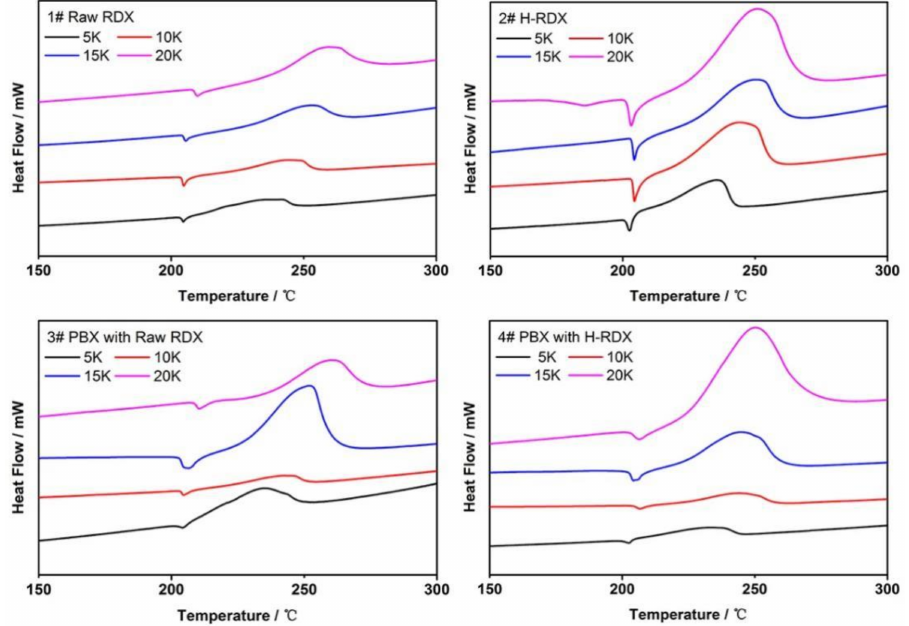
Figure 2. DSC curves of different RDX and